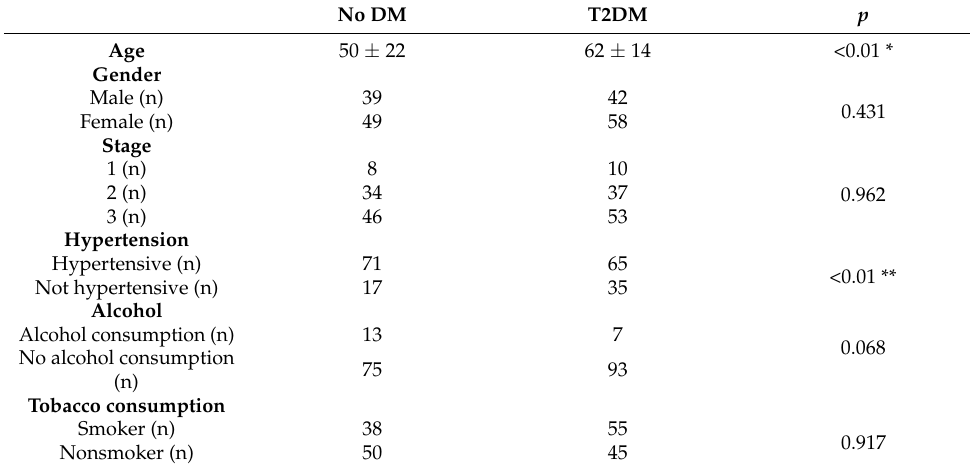
Table 4. Demographic